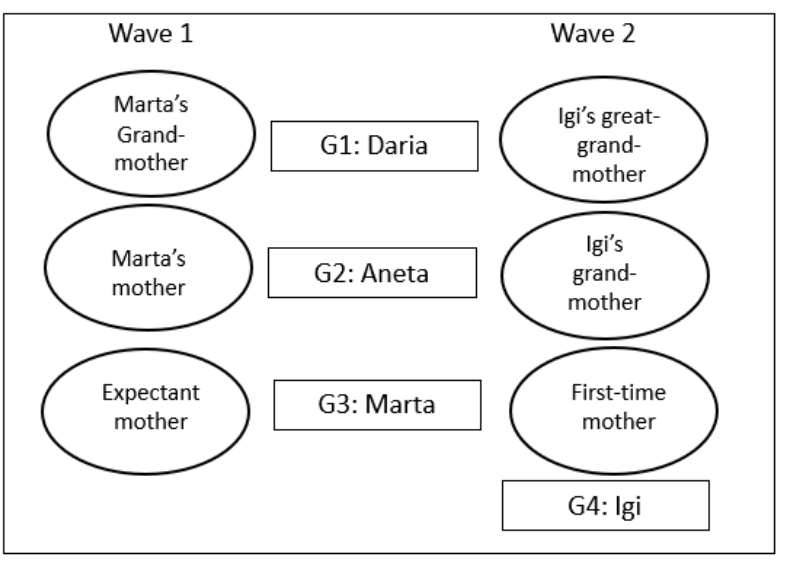
Figure 2 : Zatorski family